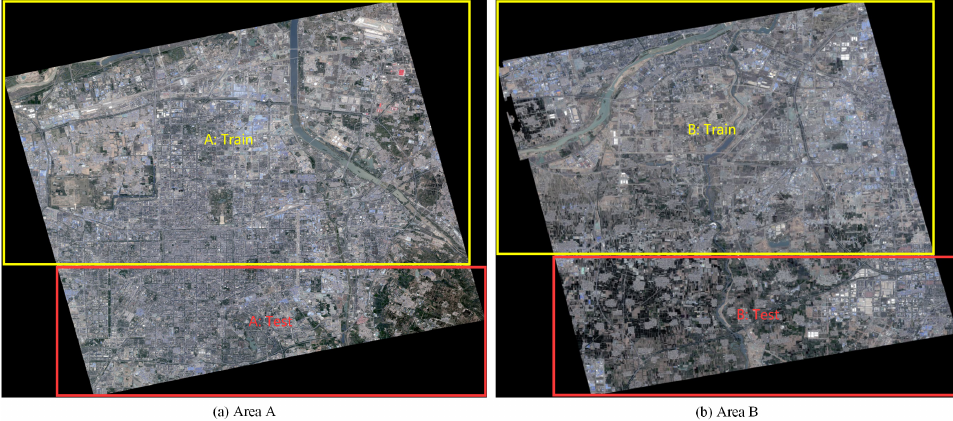
Figure 8. Road extraction dataset of Huawei Cloud